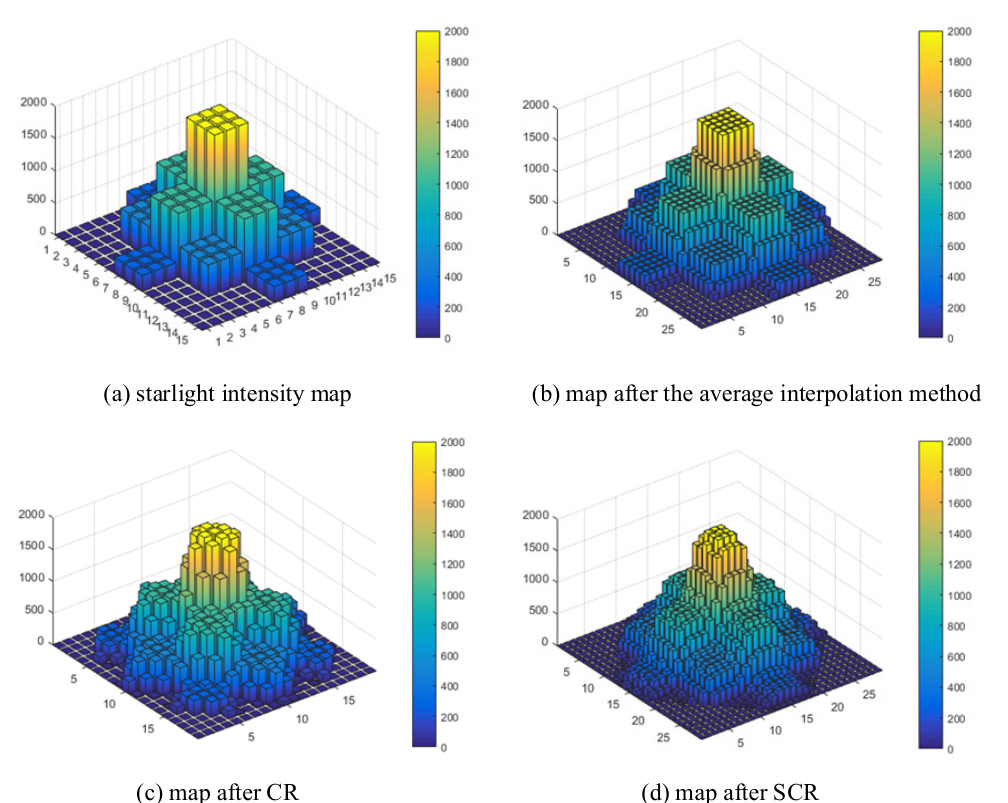
Figure 6. Pixel subdivision results by different interpolation methods.